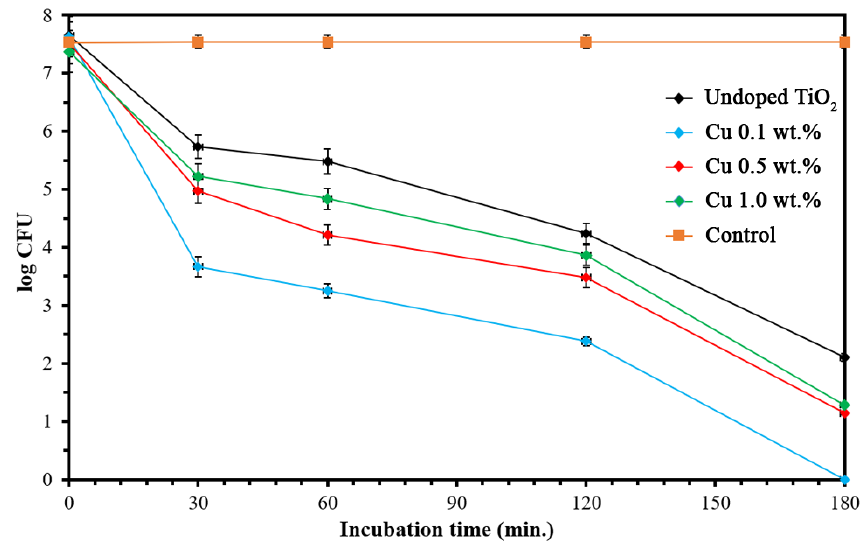
Figure 6. Antibacterial activity of undoped and Cu-doped TiO 2 nanoparticles. Cu-doped TiO 2 can perform some photokilling in dark conditions. The antibacterial property of CuO, Cu and Cu-doped TiO 2 demonstrates the high performance of killing bacteria without any radiation. The UV radiation enhanced the electron transfer and the ROS generation against bacteria cells, resulting in inactivation of bacteria cells. However, not investigated in our study. The cooperative effect of CuO and TiOs in CuO-doped TiO 2 nanoparticles was our main